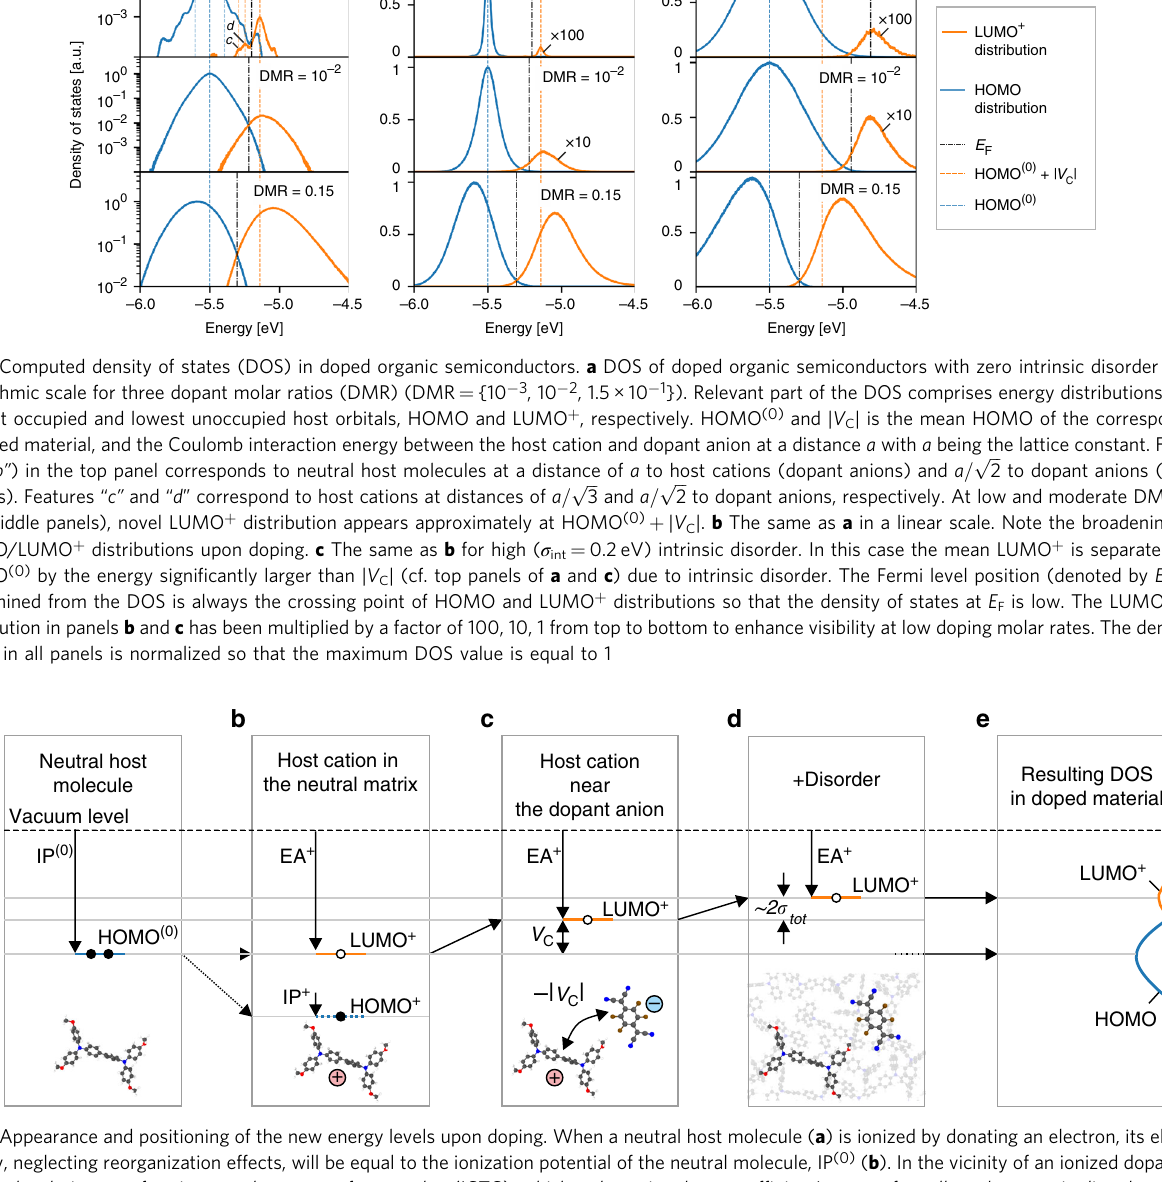
Fig. 2 Appearance and positioning of the new energy levels upon doping. When a neutral host molecule ( a ) is ionized by donating an electron, its electron af fi nity, neglecting reorganization effects, will be equal to the ionization potential of the neutral molecule, IP (0) ( b ). In the vicinity of an ionized dopant, the host molecule is part of an integer charge transfer complex (ICTC), which reduces its electron af fi nity. In case of small total energetic disorder this reduction amounts to the energy of the Coulomb interaction in the ICTC: HOMO − LUMO + = V C = − 0.36 eV (for a distance of 1 nm and ε = 4) ( c ). In presence of disorder, the LUMO + energy level is shifted up by approximately 2 σ tot ( d ) with σ tot being the total energetic disorder, resulting in the distributions in e . The second ionization energy of the host, IP + , shown in b is assumed to be signi fi cantly larger than both IP (0) and the dopant electron af fi nity, so that it is not relevant for hole transport, and the host molecule cannot be doubly Comparison to experiments . Experimentally the shift of the Fermi level with respect to the onset of the HOMO, Δ E onset , is F determined from ultraviolet spectroscopy (UPS) measurements of thin (5 – 20 nm) organic fi lms 25 – 27 . In order to account for the in fl uence of fi nite sample thickness and metallic electrodes that determine the global Fermi level, we simulated a single-layer device with a geometry similar to those used in experiment (see Methods, Supplementary Notes 2, 4 and 5, and Supplementary